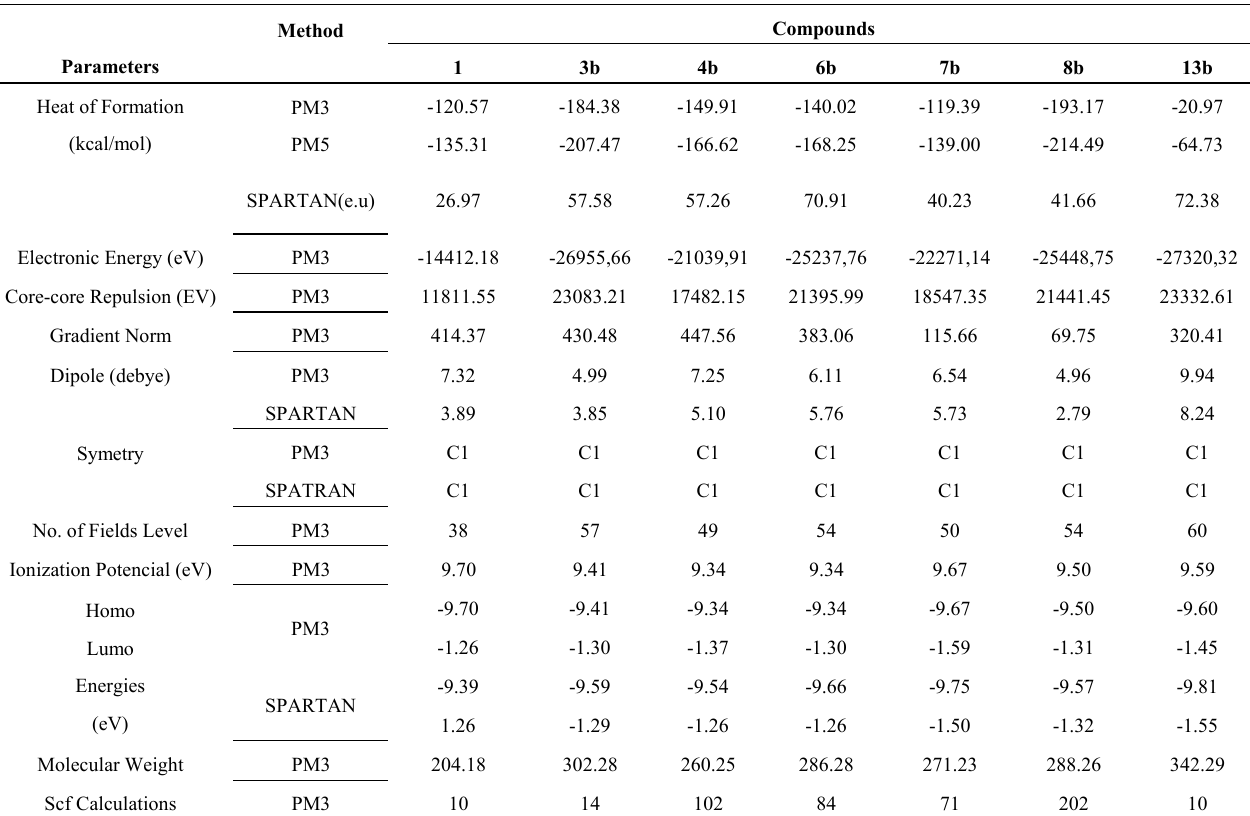
Table 2. Molecular descriptors of observed compounds.